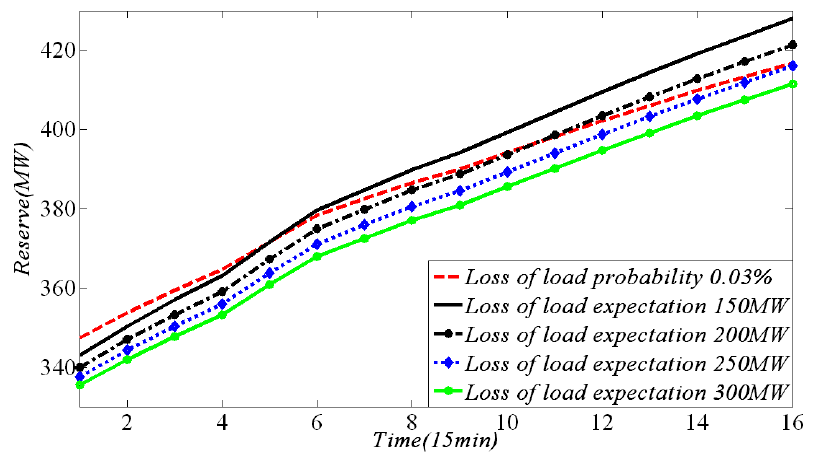
Figure 4. Relationship between the reserve and LOLE/LOLP.